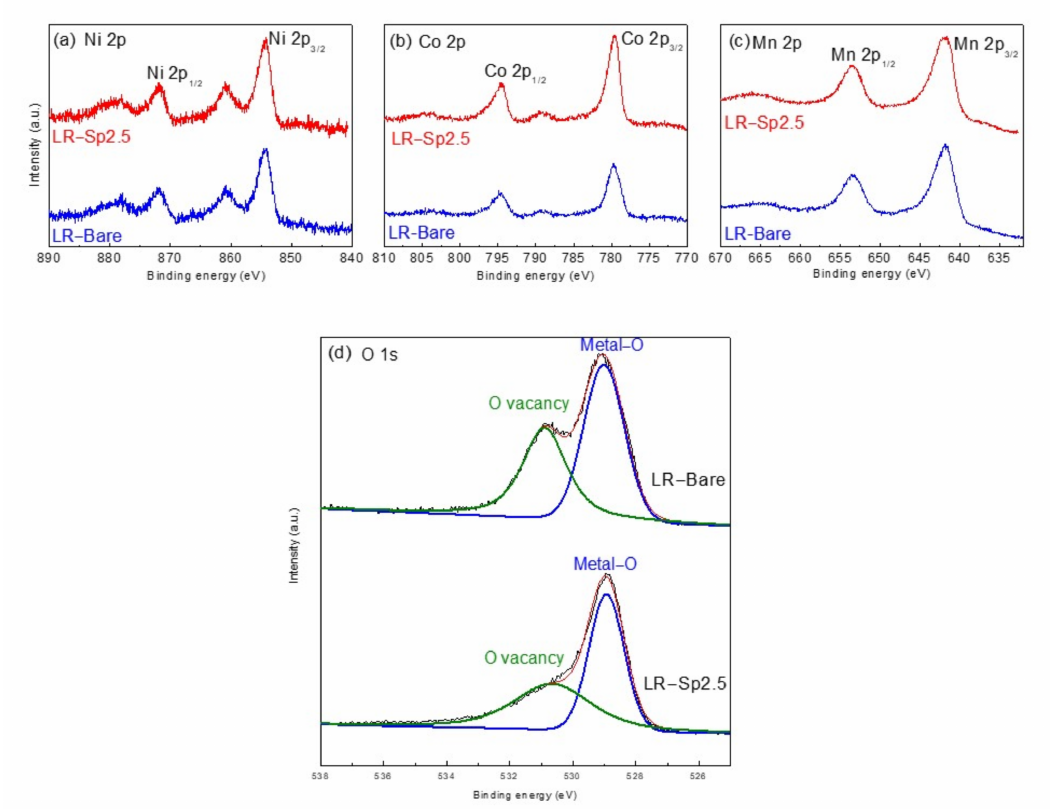
Figure 6. XPS spectra of ( a ) Ni 2p, ( b ) Co 2p, ( c ) Mn 2p, and ( d ) O 1s for LR–Bare and LR– Sp2.5